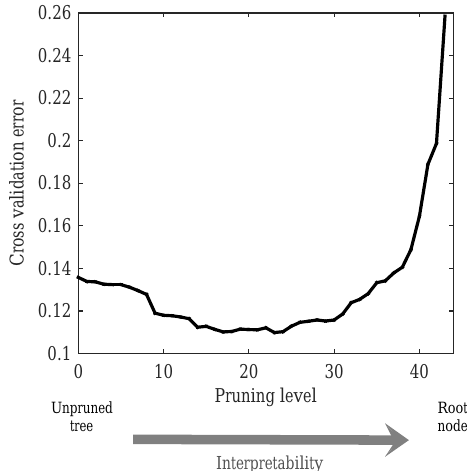
Figure A1. Cross-validation error of the classification tree for in- creasing pruning level. The cross-validation error is computed by splitting the available training data (10000 CHASM model simula- tions in our case) at random into 10 subsets. Ten different classifica- tion trees are then constructed, where each tree is trained using 9 of the 10 subsets and its misclassification rate on the remaining subset is evaluated. The average of these 10 misclassification rates is the cross-validation error (black line). The minimum cross-validation error is equal to 0.110 and is obtained at pruning level 23, which cor- responds to 51 leaf nodes. For the pruning level 31 (25 leaf nodes) the cross-validation error is